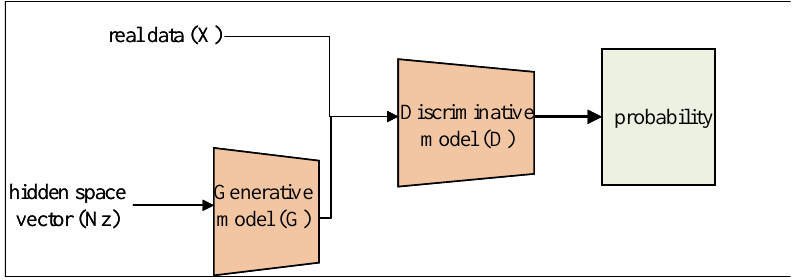
Figure 1. Construction of